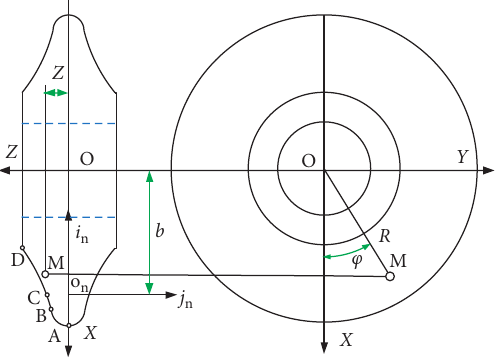
Figure 4: Model of disc milling cutter.